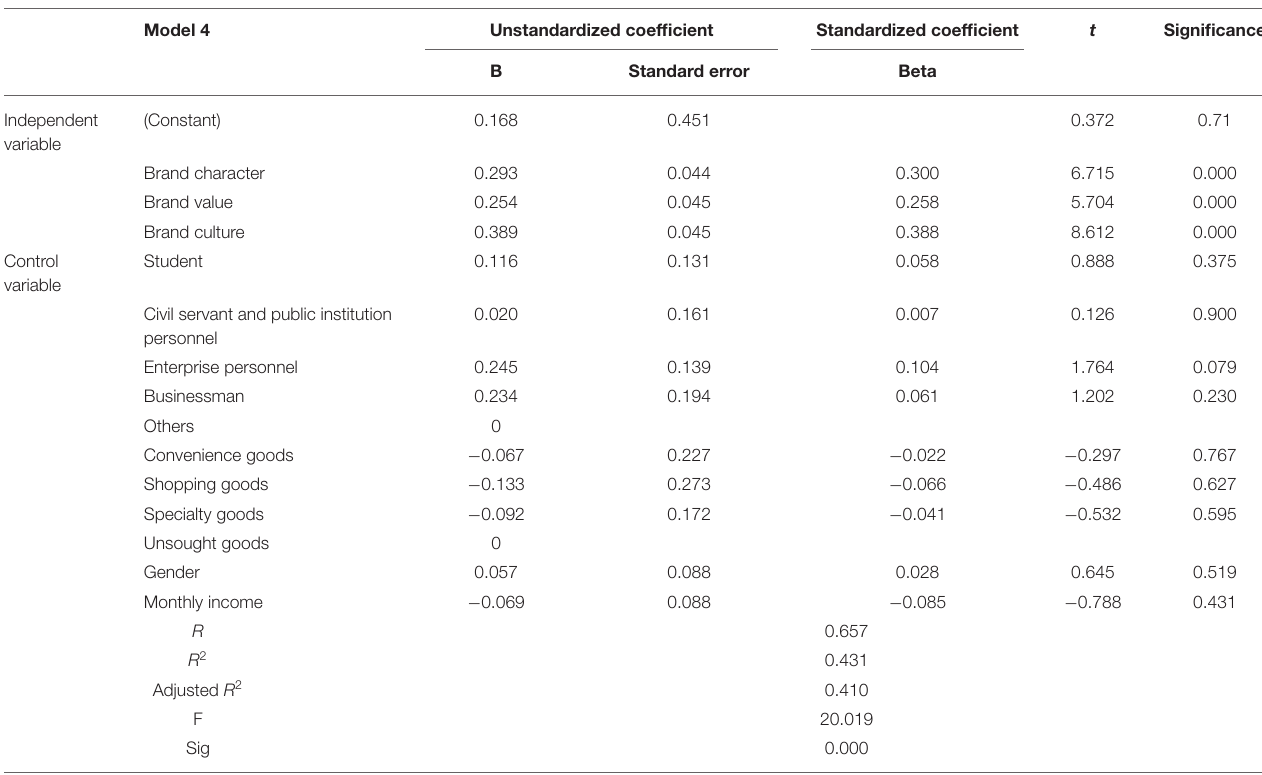
TABLE 5 | Regression analysis of each dimension of brand elements to functional